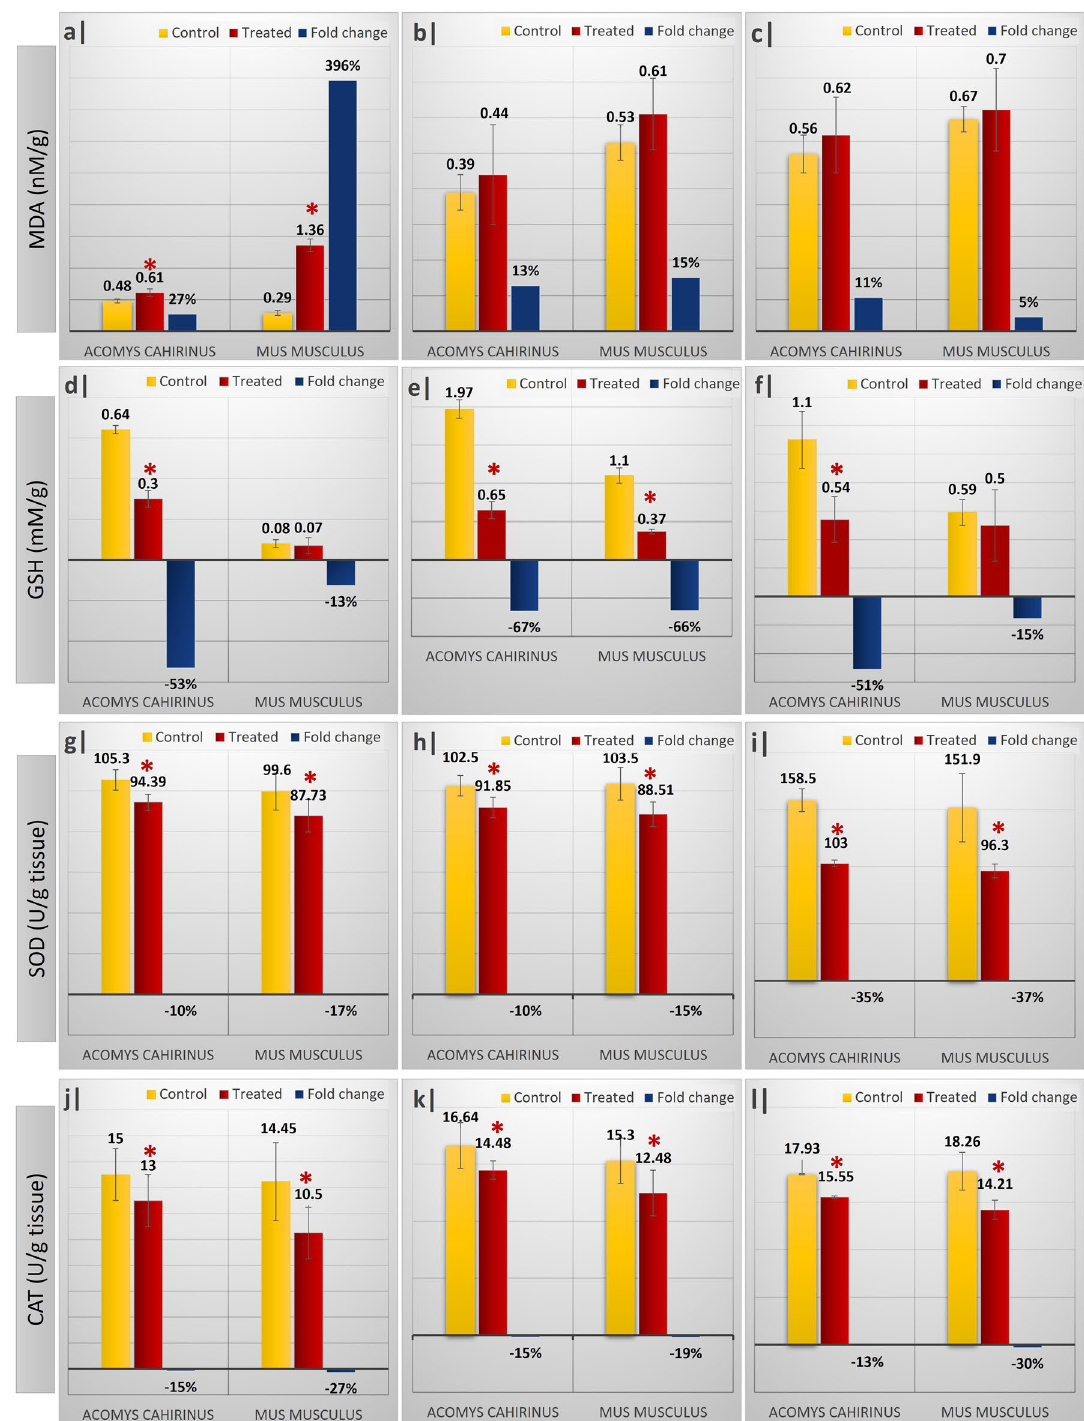
Figure 1. Effect of acute administration of LA (single dose; 400 mg/kg) on oxidative stress biomarkers: MDA brain ( a )–liver ( b )–kidneys ( c ), GSH content of brain ( d )–liver ( e )–kidneys ( f ), SOD activity of brain ( g )–liver ( h )–kidney ( i ) and finally CAT activity of brain ( j )–liver ( k )–kidney ( l ) of control and treated experimental groups of Acomys cahirinus and Mus musculus . Data presented as mean ± standard error of mean. Fold change represents the percentage change relative to the corresponding control groups. Asterisk: significant ( p < 0.05) difference as compared with the corresponding control